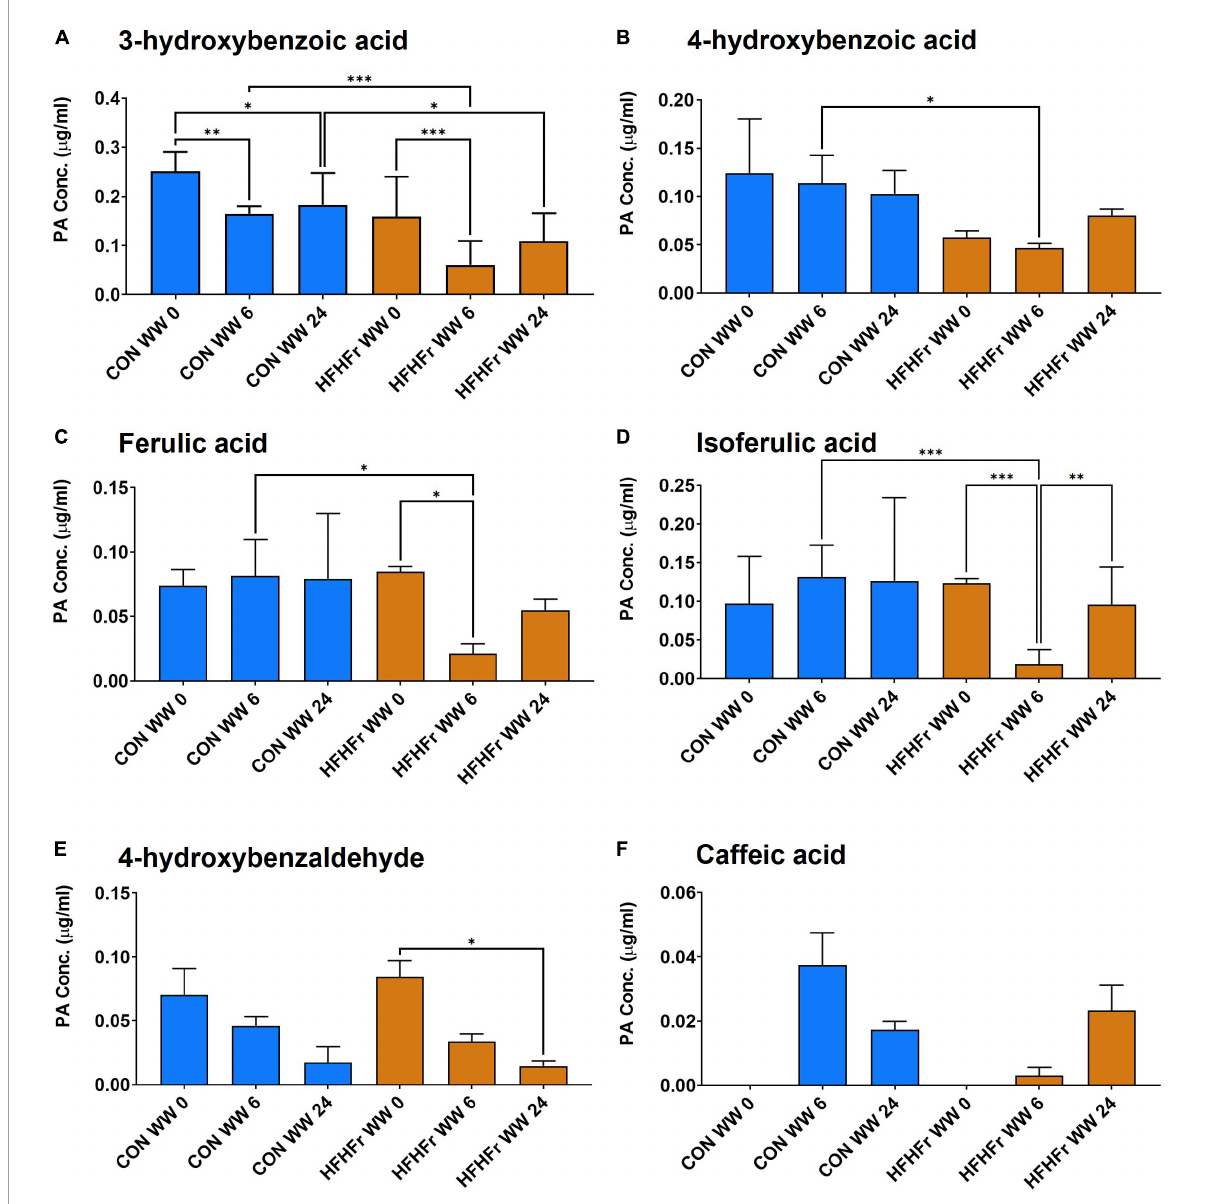
FIGURE5 Levels of selected phenolic acids (PAs, µ g/ml) measured after in vitro batch culture fermentation supplemented with digested wholegrain wheat (WW) in fecal slurry from control or HFHFr donors. The data show profiles for 3-OH-benzoic acid (A) , 4-OH-benzoid acid (B) , ferulic acid (C) , isoferulic acid (D) , 4-OH-benzaldehyde (E) , and caffeic acid (F) . Data are presented as mean ± SEM ( n = 3). ∗ P < 0.05; ∗∗ P < 0.01 (two-way ANOVA and Sidak’s multiple comparison’s test). *** P <